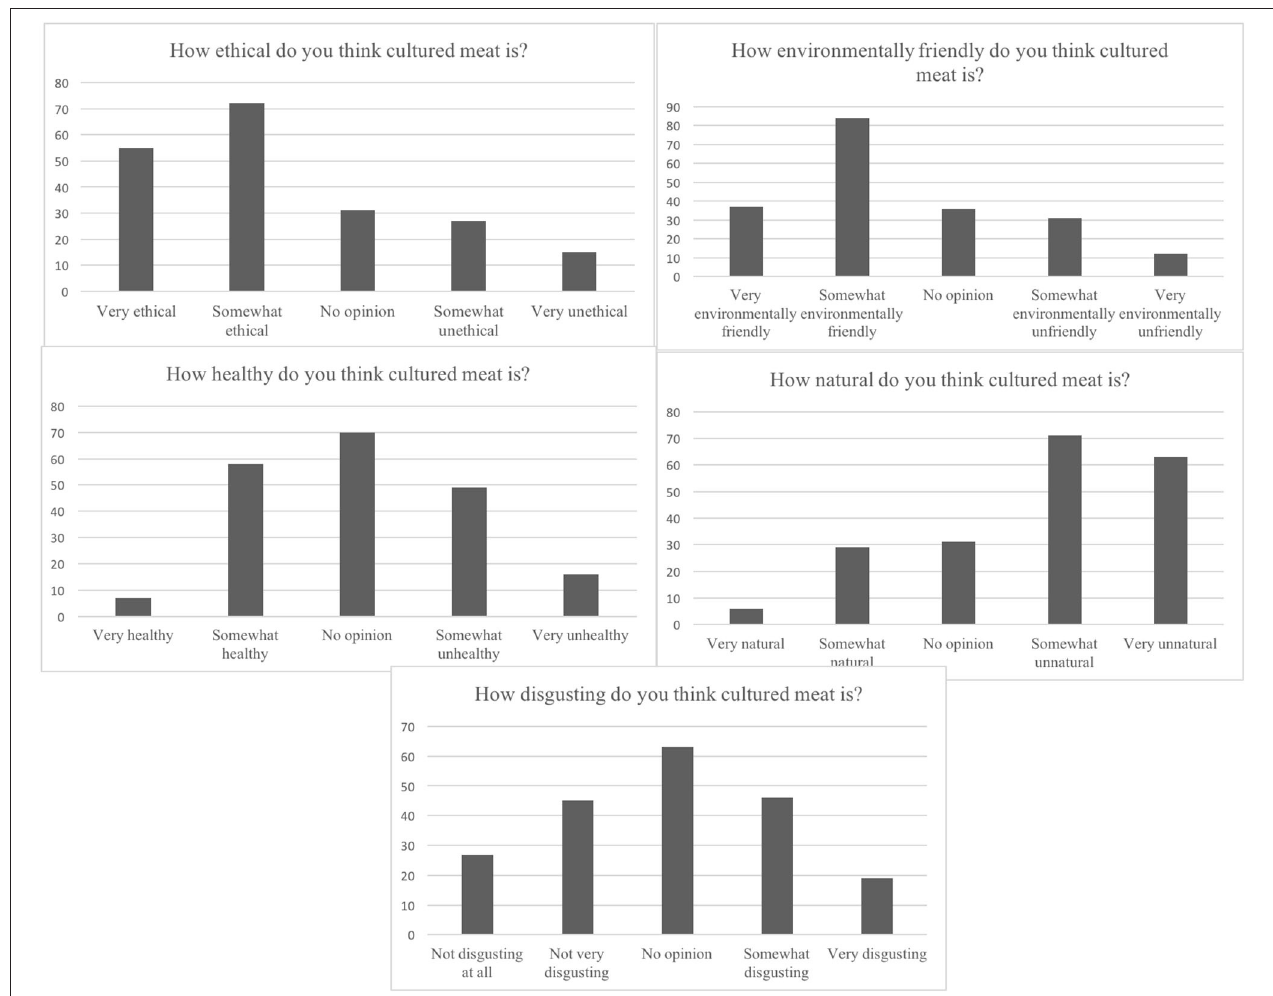
FIGURE 1 | Attitudes regarding naturalness, ethics, environmental friendliness, disgust, and healthiness of cultured meat (frequency response).